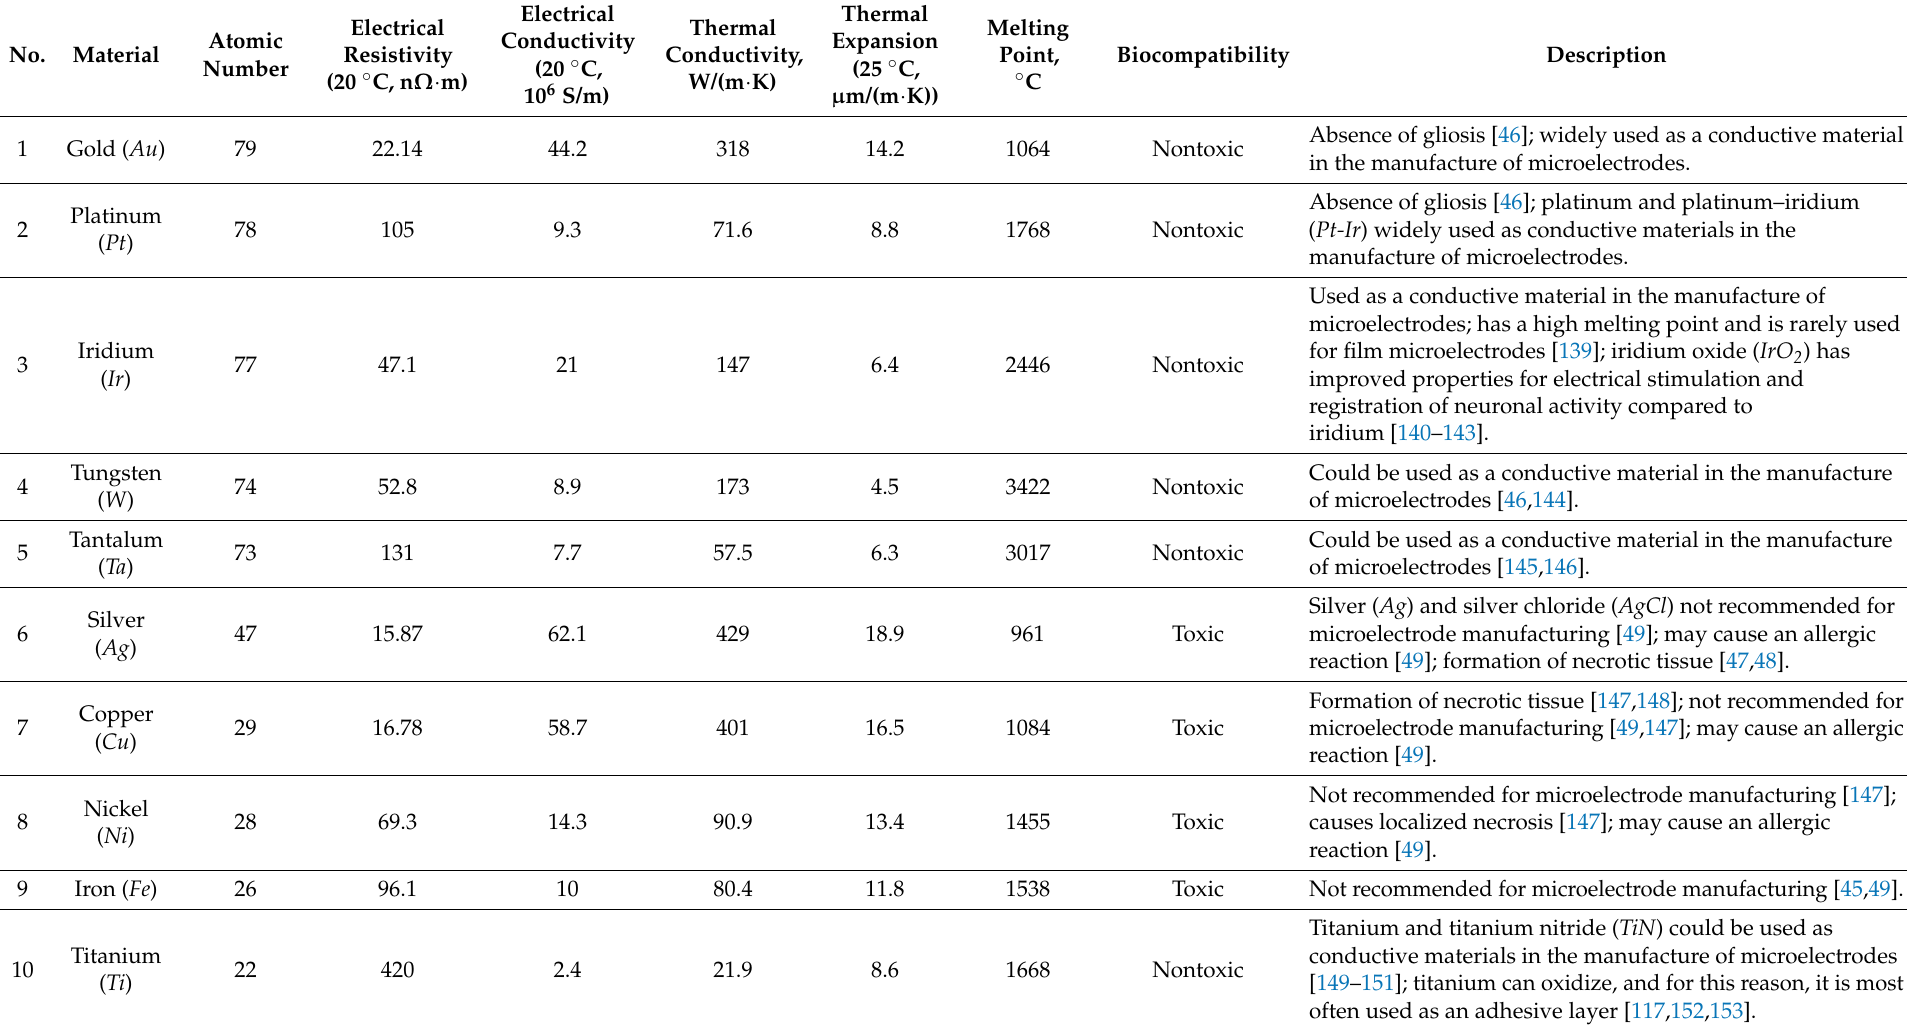
Table 1. Conductive materials for